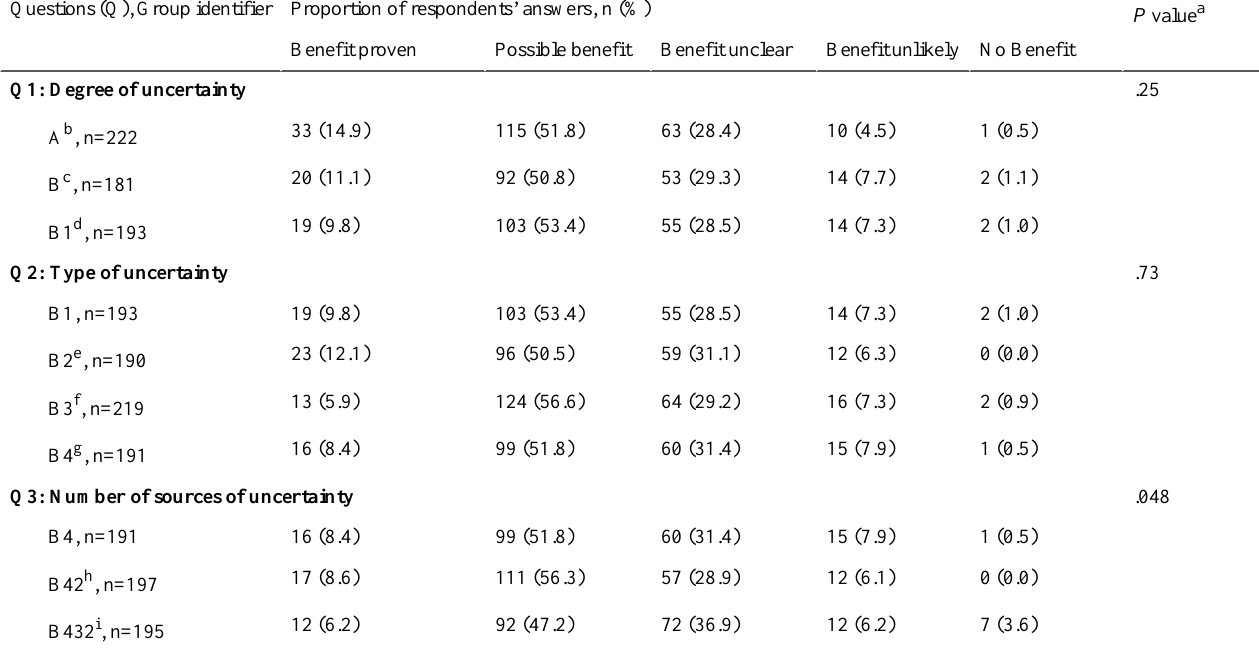
Table 3. Results of the primary outcome (perception of treatment